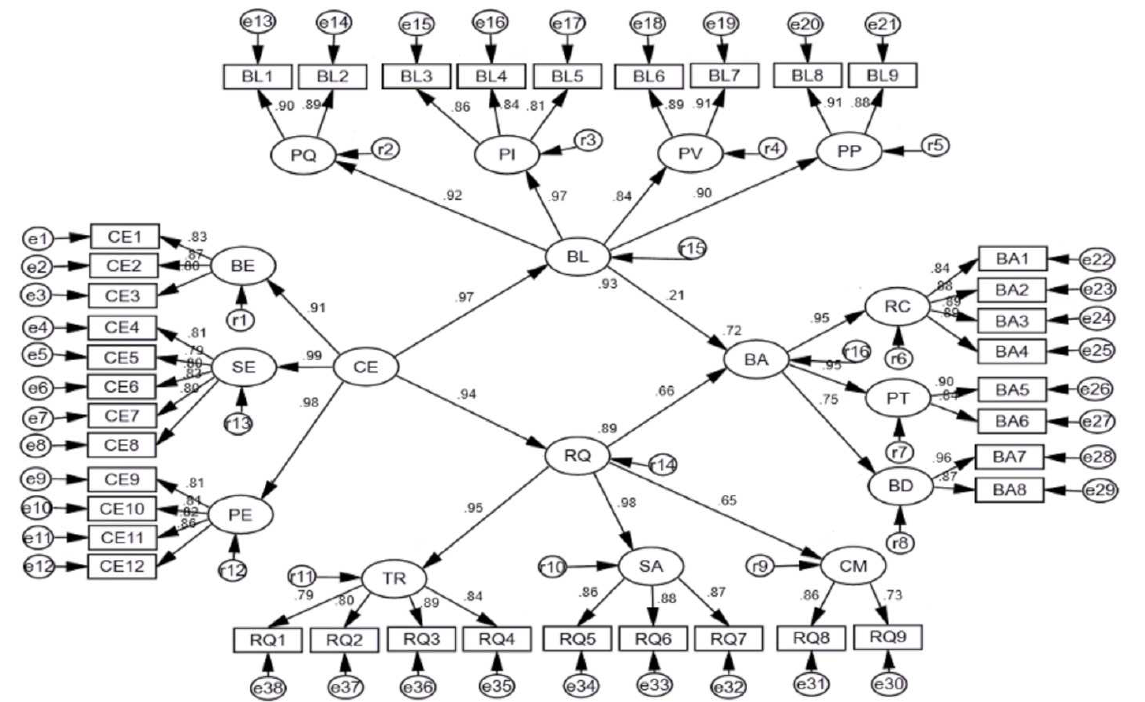
Figure 2. SEM result of building brand advocacy in online food